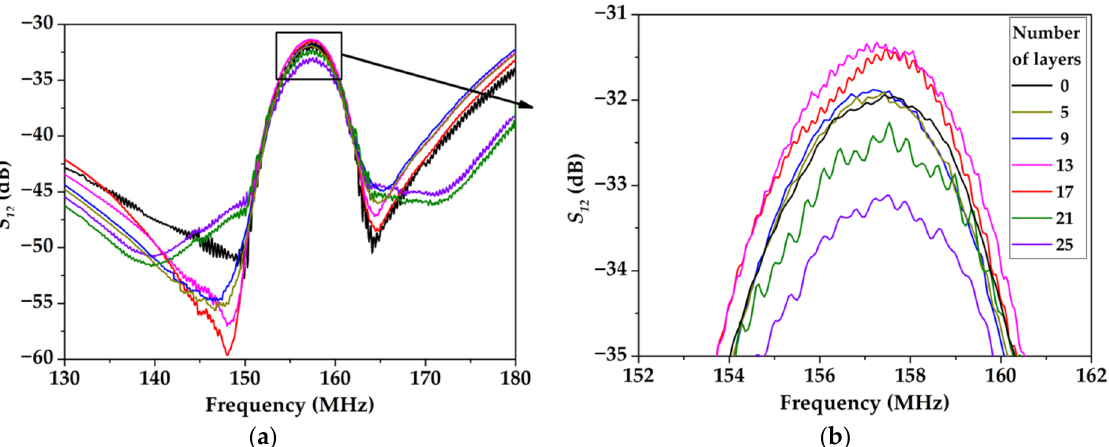
Figure 9. ( a ) The frequency dependencies of the S 12 parameter for device #2 loaded by LB film consisting of different number monolayers of SA; ( b ) enlarged fragment.